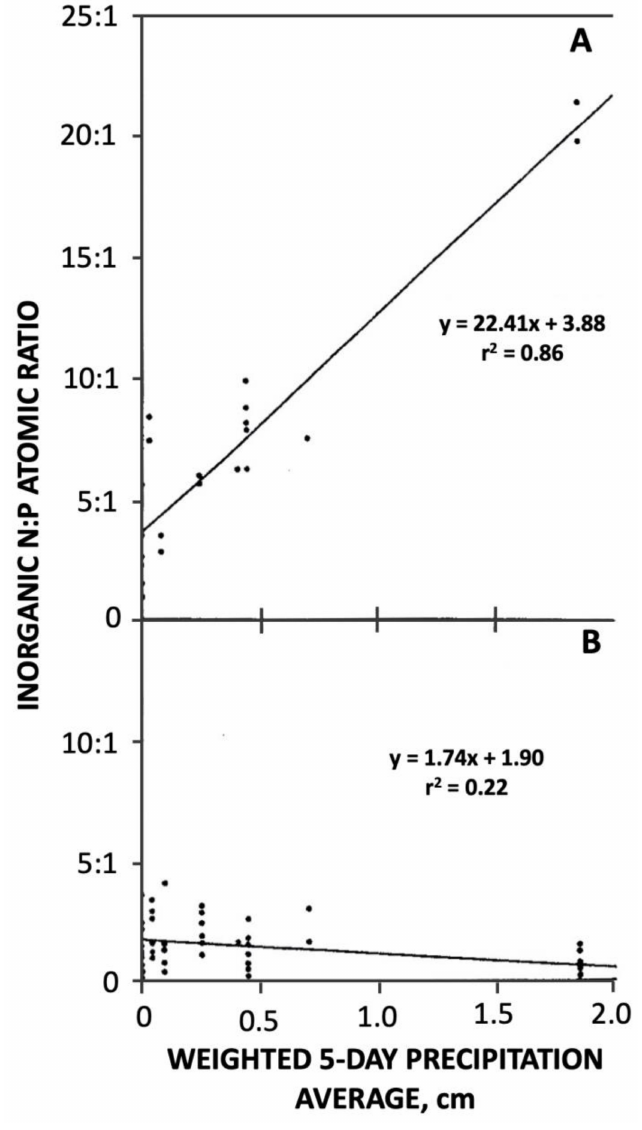
Figure 8. The relationship of weighted 5-day precipitation average prior to sampling of inorganic N/P ratios in ( A ) Bayou Chevreuil and ( B ) natural swamp [50]; data collected 1982–1983. Table 2. Range of mean values from all storm events for total suspended sediment (TSS) and nutrient concentrations (mg/L) in stations receiving agricultural runoff in the upper Barataria Basin (from [48,49]; data collected 2005–2006). Peak values in